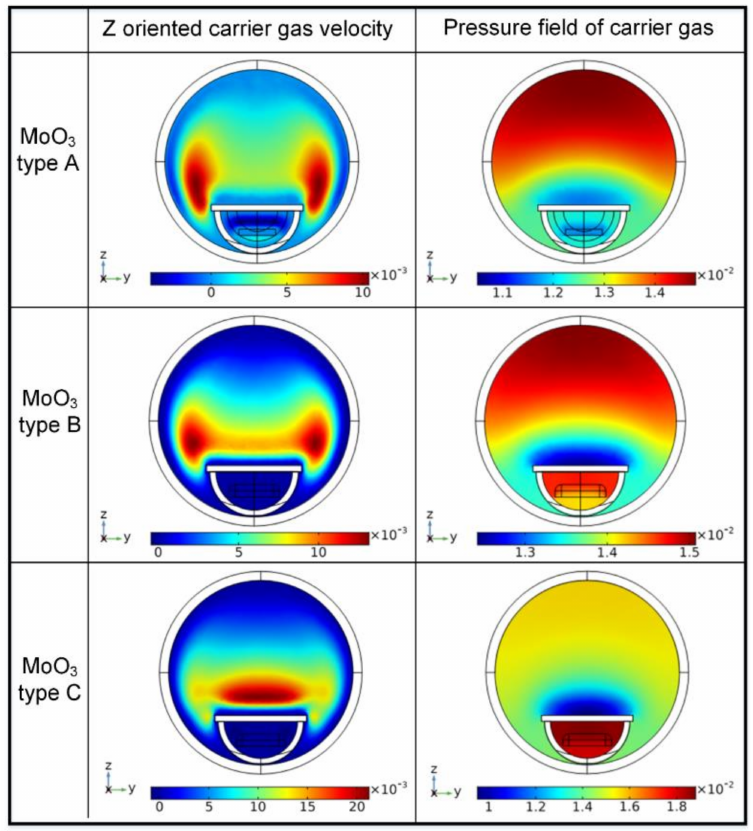
Figure 6. Z oriented velocity (in m/s) and pressure field of carrier gas flow (in Pa) under different